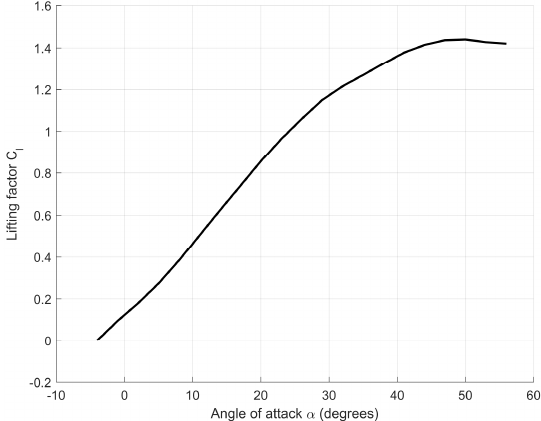
Figure 5. Dependence of lifting factor on the angle of attack for glider simulation.